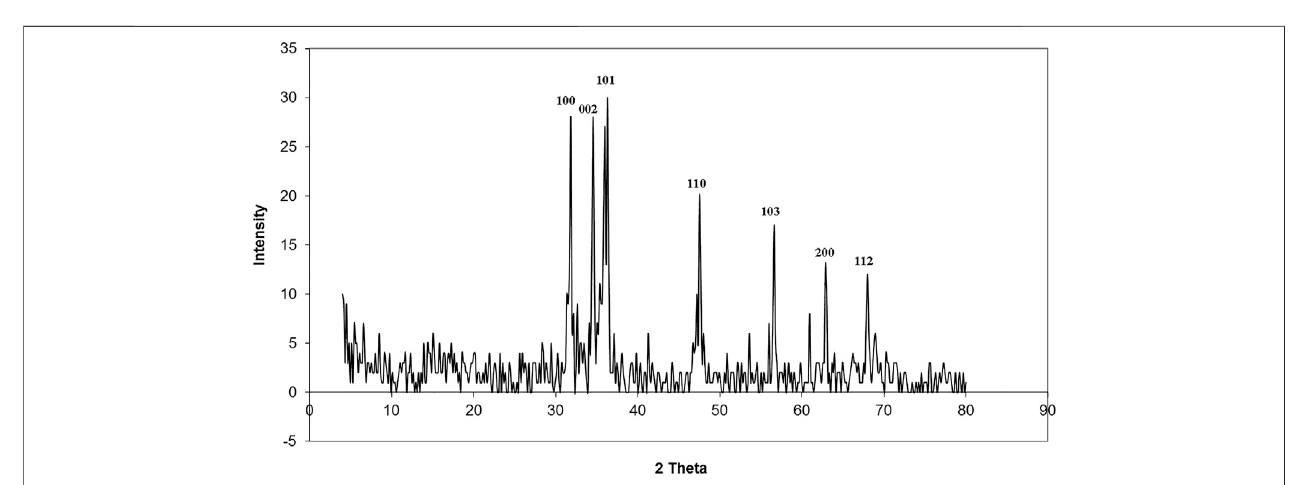
FIGURE 2 | XRD patterns of ZnO nanorods